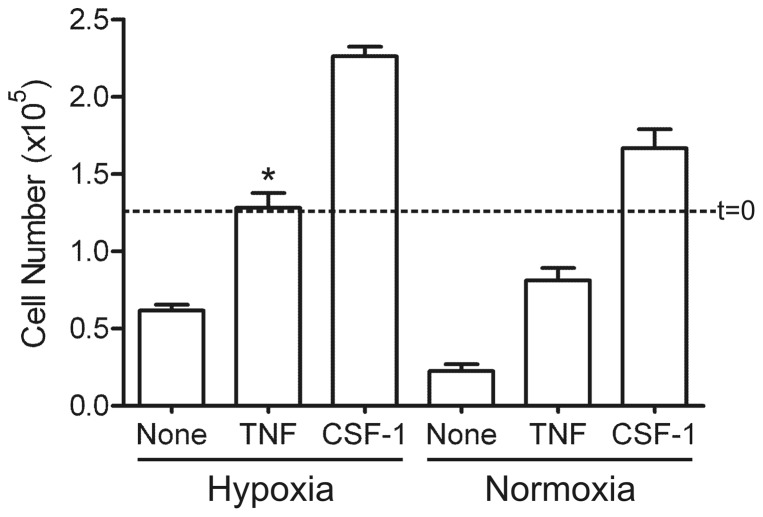
Enhanced BMM survival by TNF in normoxic and hypoxic conditions.BMM were depleted of CSF-1 and left untreated or treated with TNF (10 ng/mL) or CSF-1 (5000 U/mL), under hypoxic or normoxic conditions for 2 days. Viable cell number was counted; t = 0, initial cell number. Data are mean values (± SEM) from triplicate cultures from a representative experiment (n = 5). *, p<0.05 (Student's t-test) vs. TNF-treated group in normoxia.